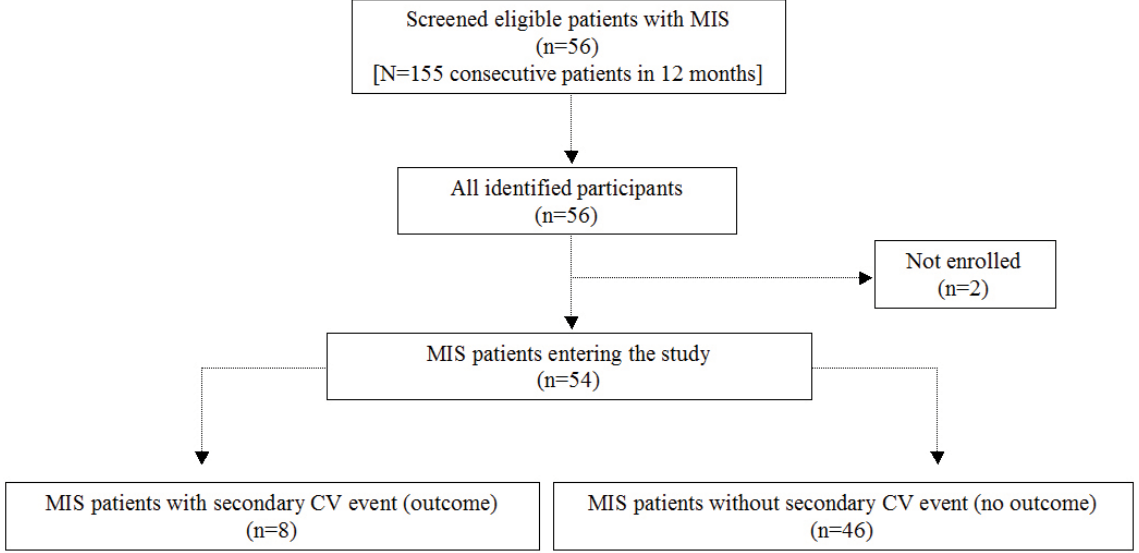
Figure 1. CONSORT flow-chart of study screening, enrolment and